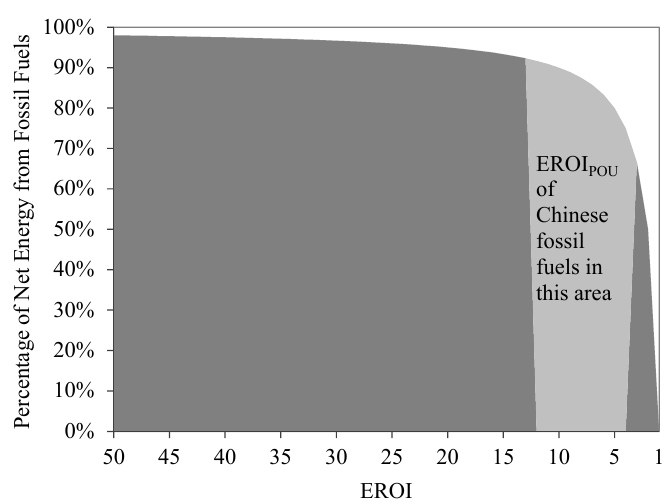
Figure 11. Net Energy Cliff of Conventional Fossil Fuels in China based on the EROI POU results in this study. The relationship between net and gross energy is called the “Net Energy Cliff”. Mearns [22], Murphy and Hall [46] have discussed this relationship and noted a declining relationship between gross and net energy.